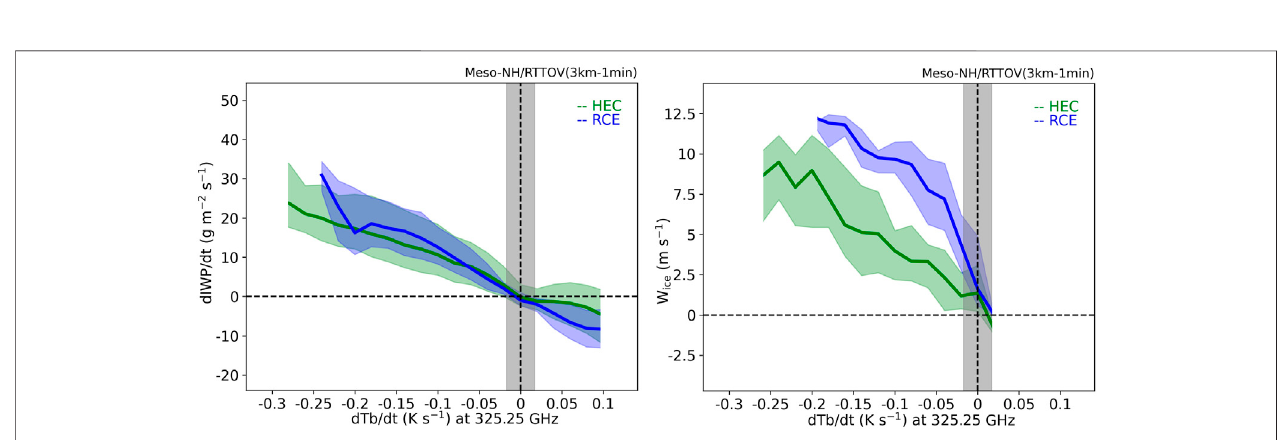
FIGURE 7 | Same as Fig. 6, but for the 325.25 GHz channel and at 3 km resolution.